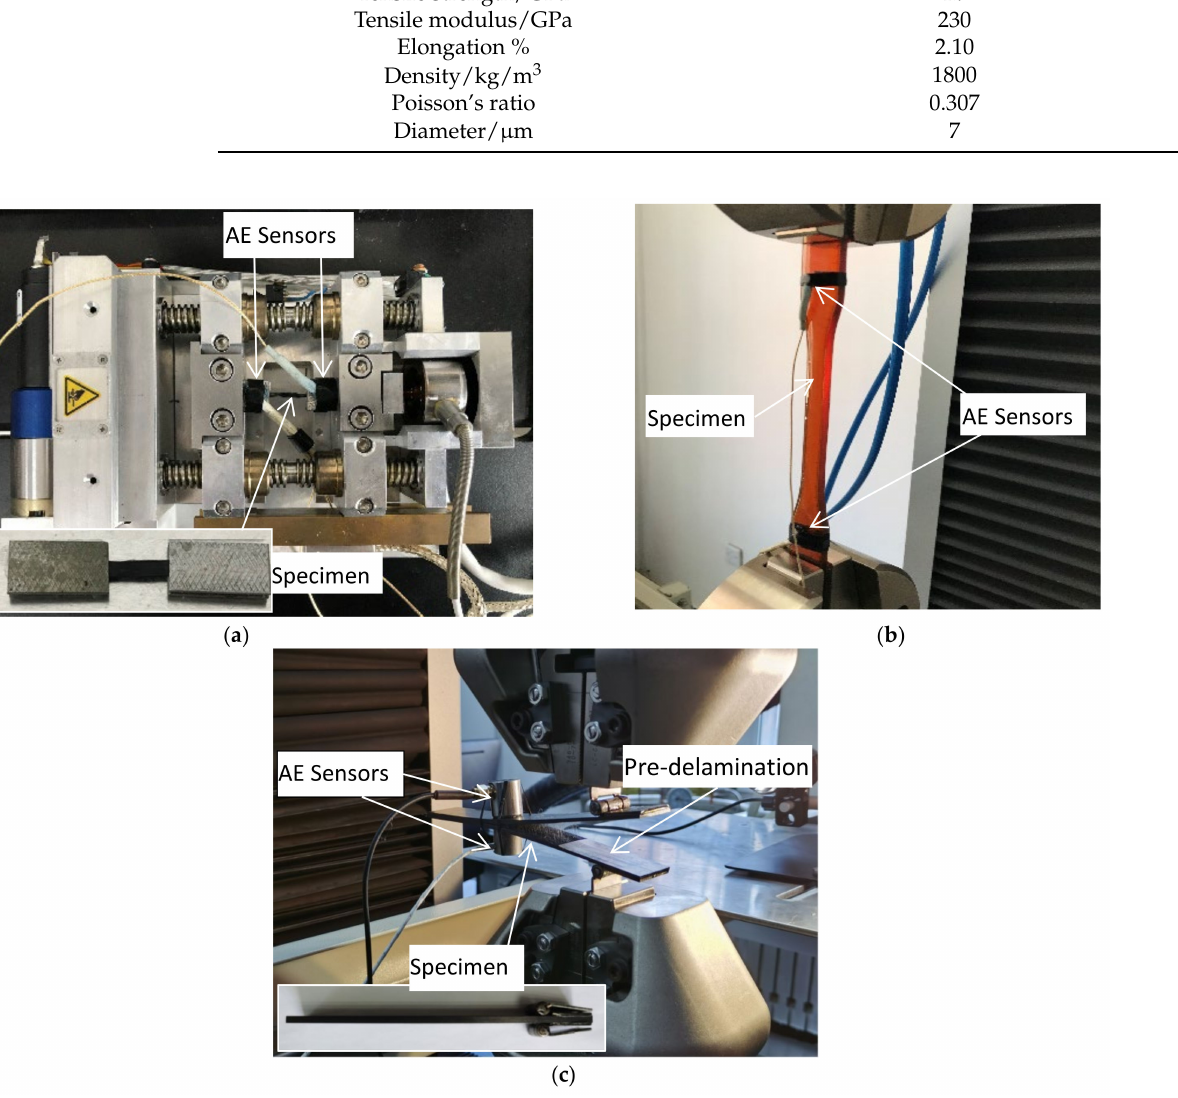
Figure 1. Experimental setup: ( a ) fiber bundle tensile test; ( b ) matrix tensile test; ( c ) delamination